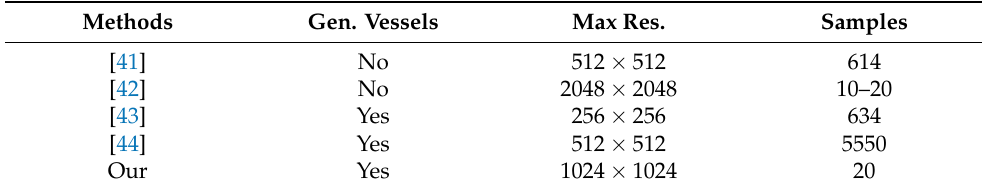
Table 1. Comparison with other generation approaches.